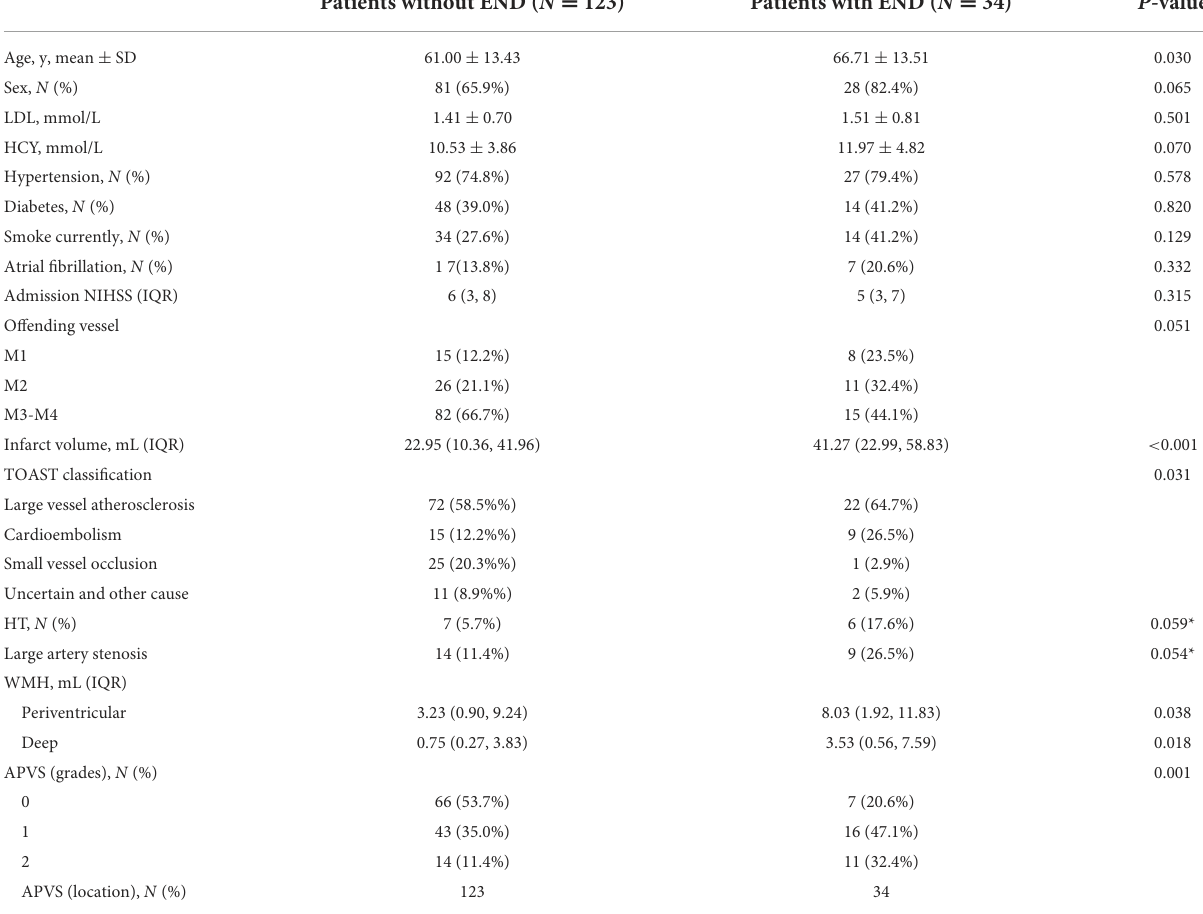
TABLE 1 Clinical characteristics of patients with and without END. Patients without END ( N = 123) Patients with END ( N = 34) P -value